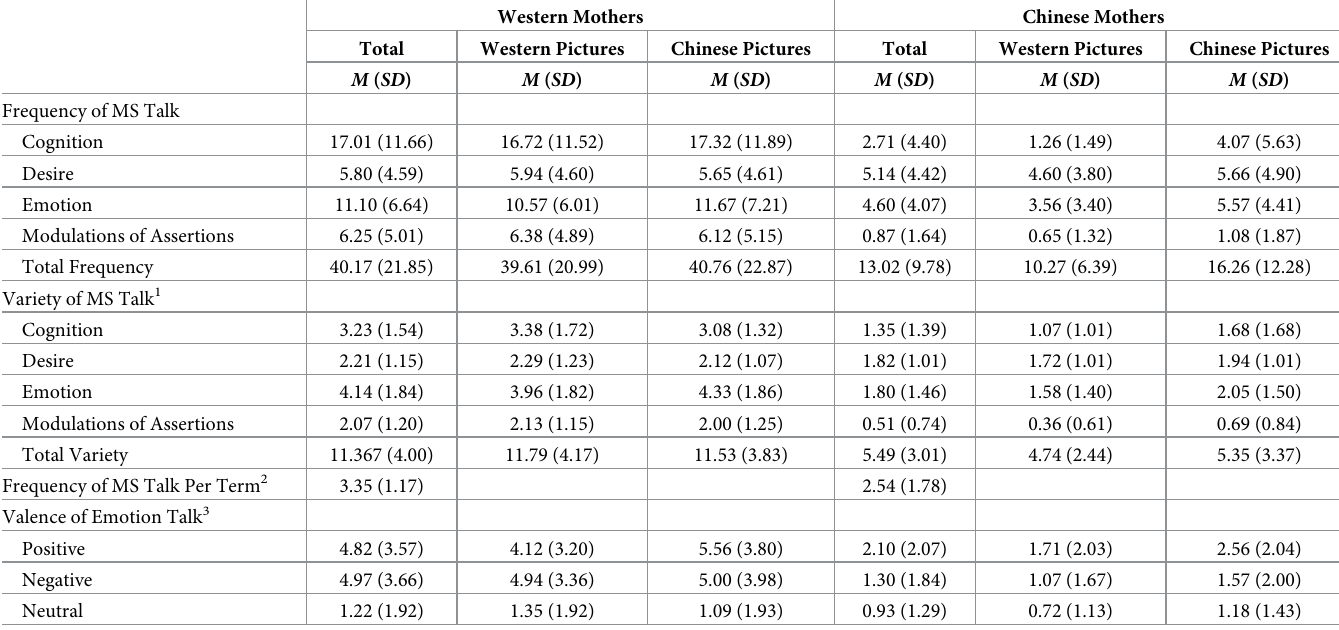
Table 2. Descriptive statistics for each type of MS language in Westerners versus